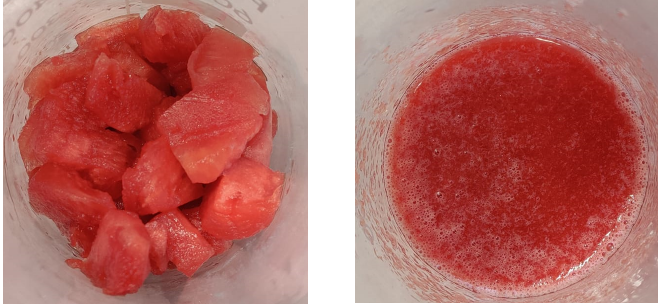
Figure 8. Watermelon ( Citrullus lanatus ) variety Gavina ®® pomace: natural ( left ) and homogenized ( right